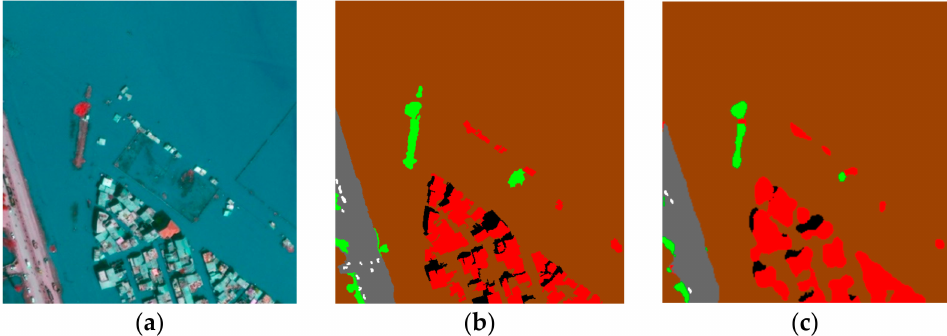
Figure 17. ( a ) Remote sensing scene of urban floods. ( b ) Manually annotated ground truth for the scene. ( c ) Multi-class segmentation result predicted by using SegNet with ResNet